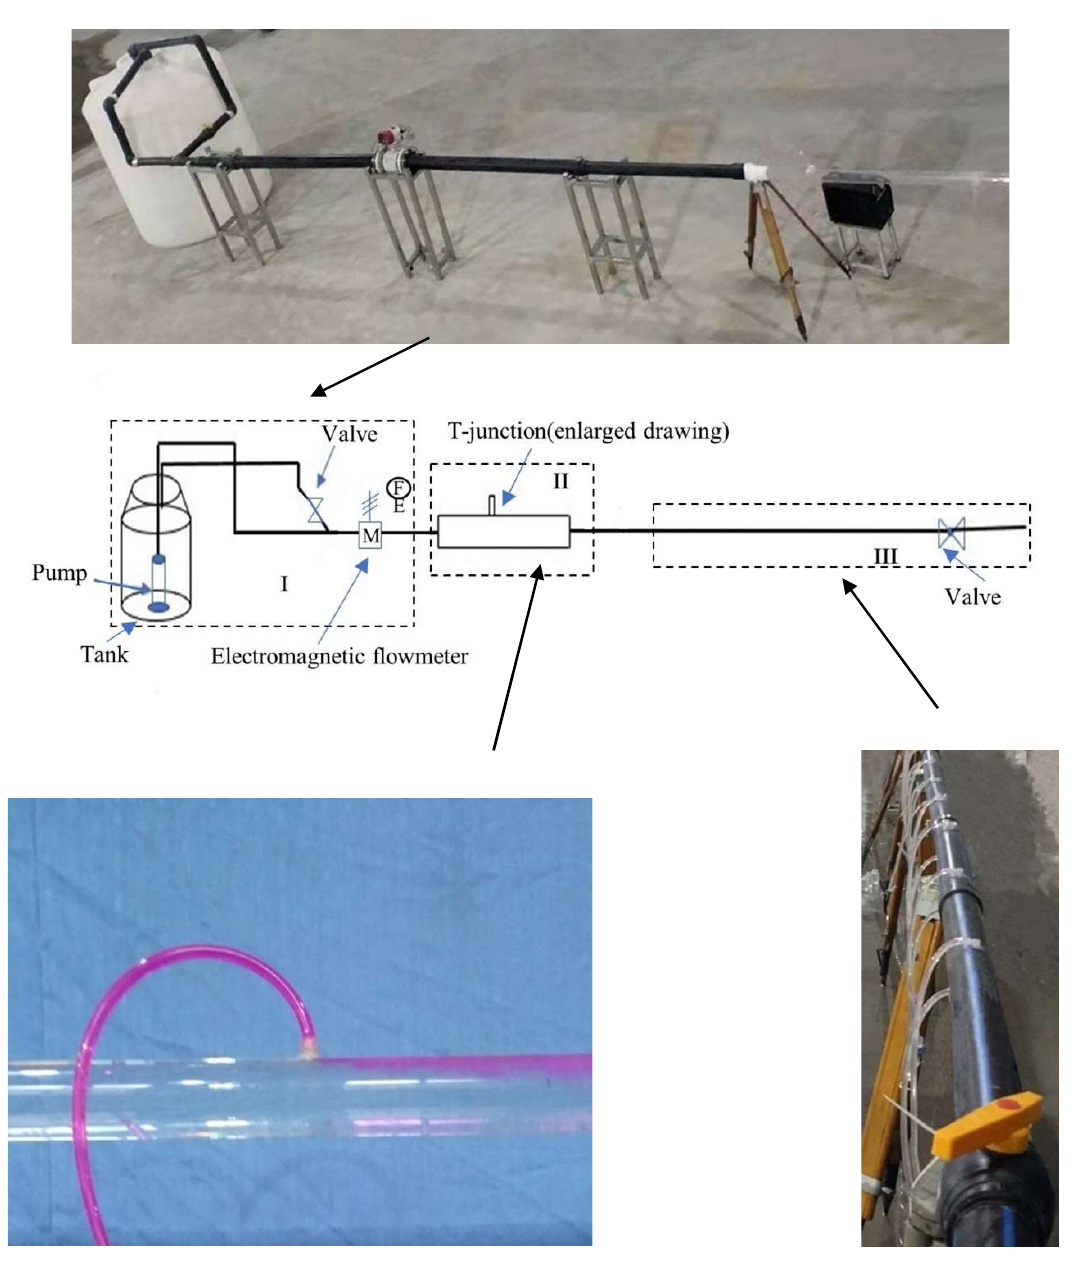
Figure 3. Schematic diagram of the model test layout accompanied by some photographs.